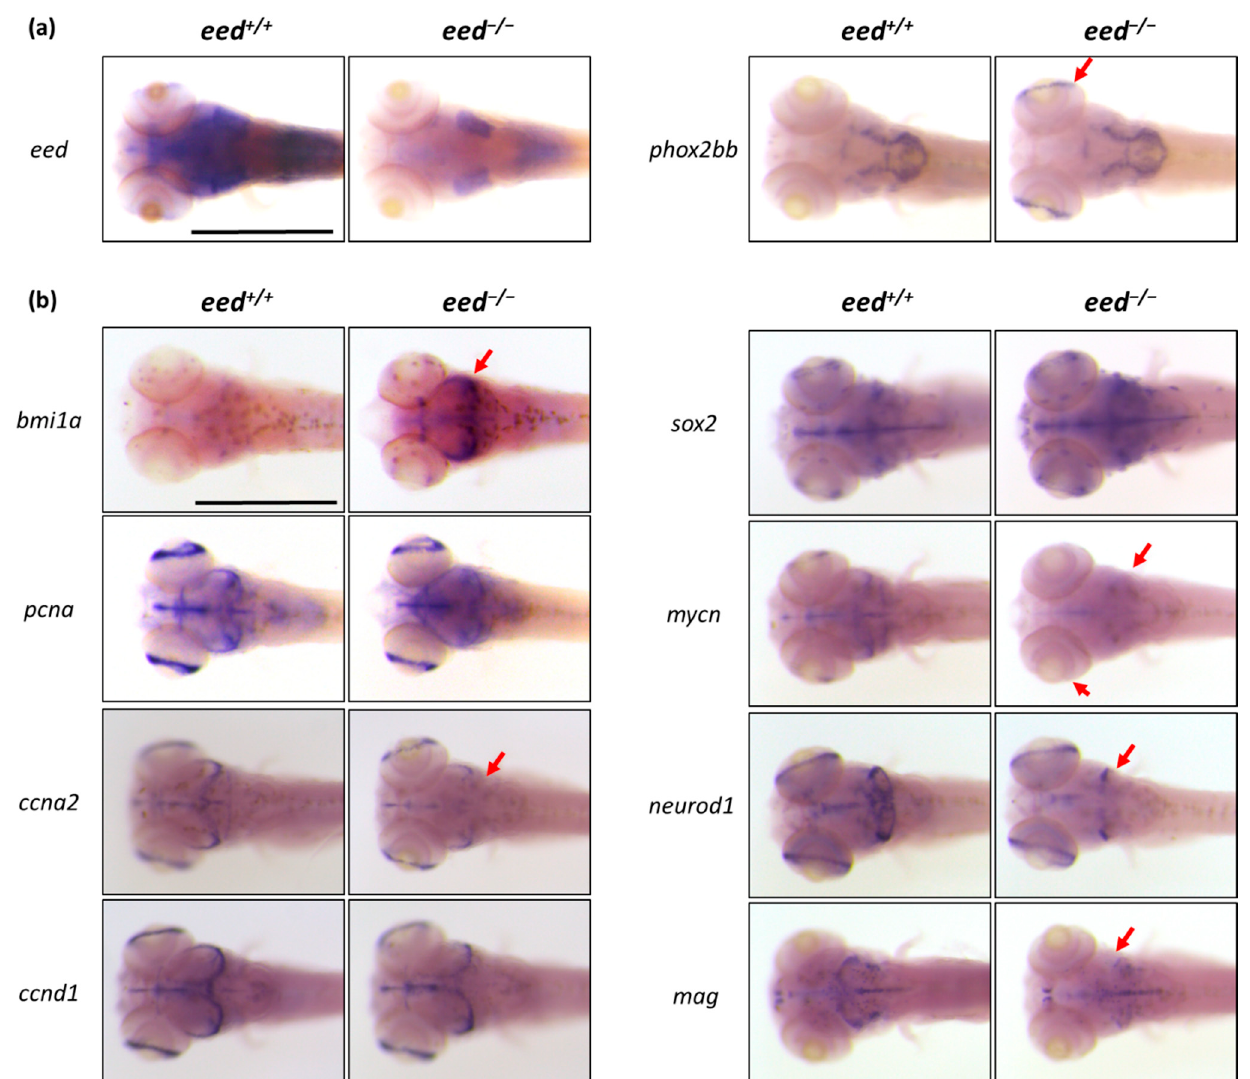
Figure 7. Whole ‐ mount RNA in situ hybridization of the brain region of eed +/+ and eed ‐ / ‐ siblings at 5 dpf: ( a ) whole ‐ mount in situ hybridization to detect eed (left) and phox2bb RNA expression. The red arrow shows the phox2bb ectopic expression in the retina of eed mutants. Scale bar is 500 μ m; ( b ) whole ‐ mount in situ hybridization to detect the expression profiles of stemness ( bmi1a , sox2 ), proliferation ( pcna , mycn ), cell cycle ( ccna2 , ccnd1 ), and neuronal/glial precursor ( neurod1 , mag ) markers. The red arrows emphasize expression profile differences between eed +/+ and eed ‐ / ‐ larvae. Scale bar is 500 μ m.